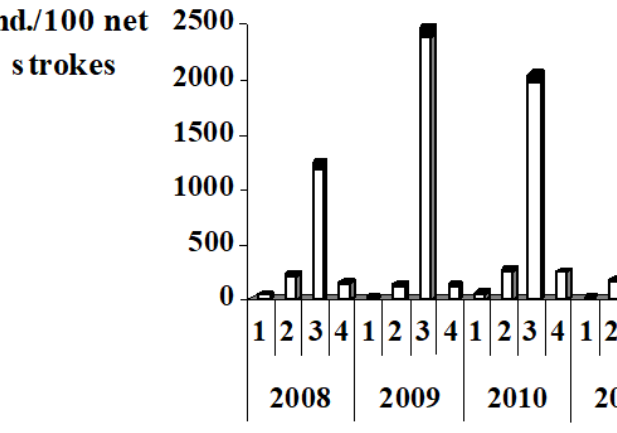
Figure 1. Abundance of adult wheat thrips and adult predatory and striped thrips in agrocenoses of winter wheat, ind./100 net strokes.